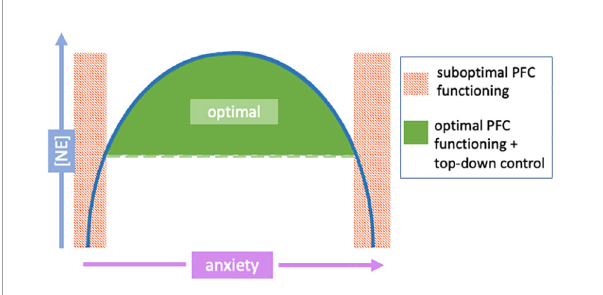
FIGURE3 The relationship between norepinephrine (NE) levels and anxiety follows an inverted-U shaped correlation. The relationship of NE release and anxiety levels follows an inverted-U shape. Green areas indicate moderate and manageable arousal/anxiety levels as a result of moderate NE release; this area of a “happy medium” allows continued optimal prefrontal cortex (PFC) functioning and top-down control (and thus, normal behavior). Red shaded areas show areas of either hyper- or hypo-NE release, causing the PFC to be taken “offline” causing loss of necessary regulatory control over other brain regions (impaired PFC-dependent functions). Modified from Arnsten